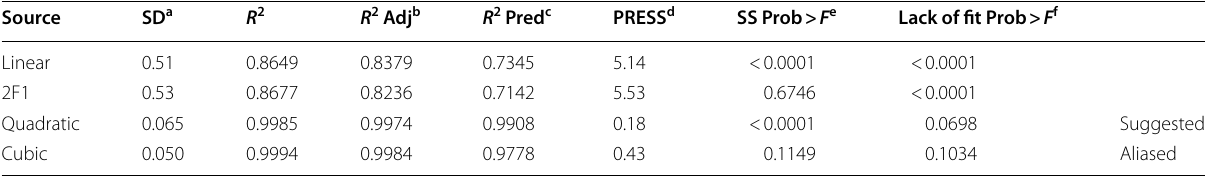
Table 6 Suggested model summary statistics